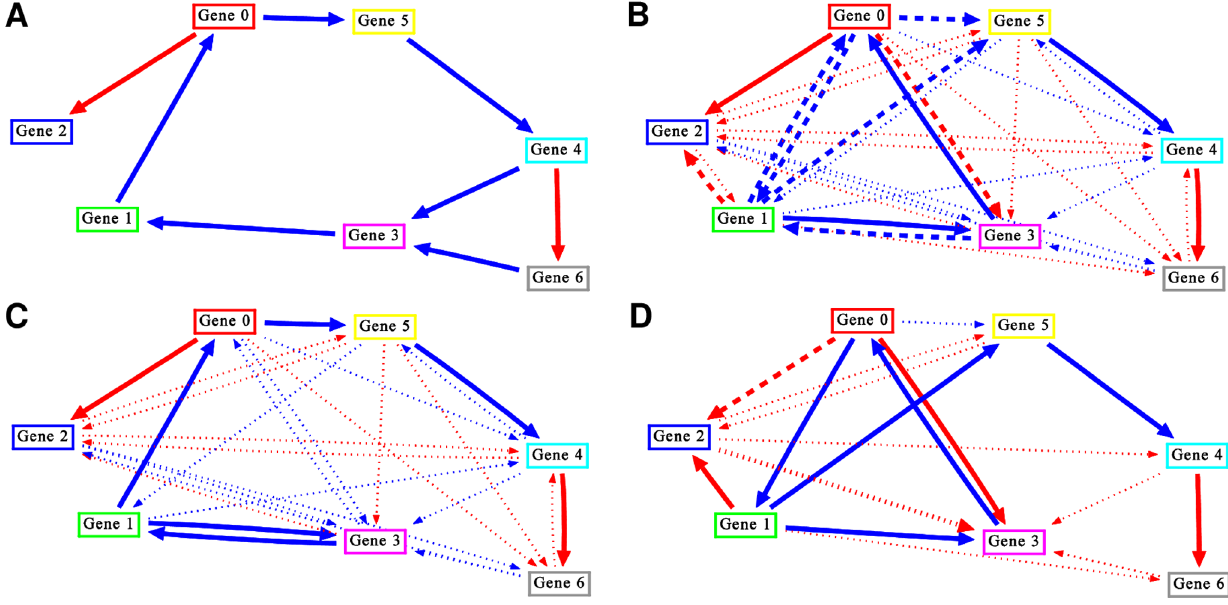
Figure 3. Example for extracted group-ensembles. Using simulated data from a random reference network (A), the applied reverse- engineering algorithm created a set of networks which were combined to an ensemble (B). Two group-ensembles (C,D) were derived using the described characteristic interaction set extraction approach. Both group-ensembles explain the simulated data very well (average RMSD 0.075 and 0.081) but effector-target relations differ strongly (AUPRC to reference 0.898 and 0.311). Blue lines: activating interactions. Red lines: inhibiting interactions.